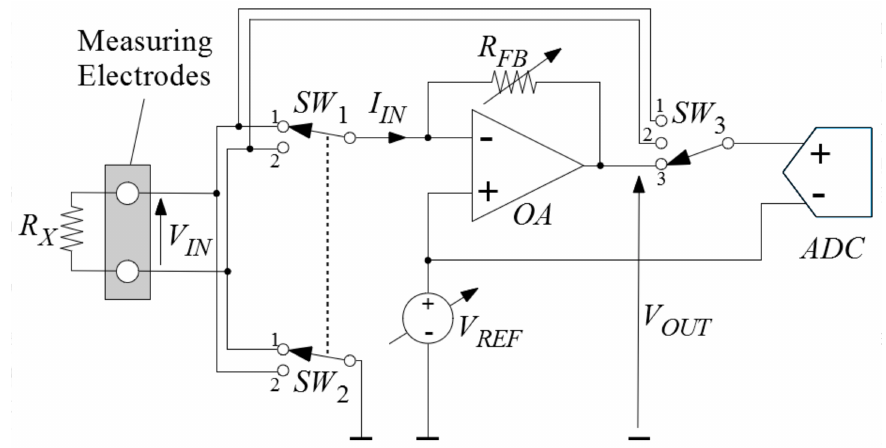
Figure 1. Basic schematic diagram of the resistance measuring circuit ( OA —the operational amplifier, V REF —the programmable reference voltage source, R FB —the programmable resistor in the feedback loop, R X —the unknown resistance, SW 1 , SW 2 , SW 3 —the switches, ADC —the analog-to-digital